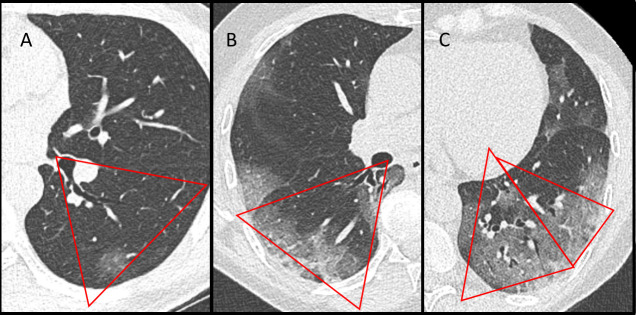
Illustration of how to calculate the COVID19-LDCT score.A. The triangle with red borders shows the 6th segment of the left lung with a unique GGO corresponding to minimal impairment. B. The triangle with red borders shows the 6th segment of the right lung with GGO inside involving 50% of the segment corresponding to intermediate impairment. C. Two triangles showing the 10th and the 9th segments of the left lung, where the extent of GGO was > 50% and 50%, corresponding to severe and intermediate impairment, respectively.